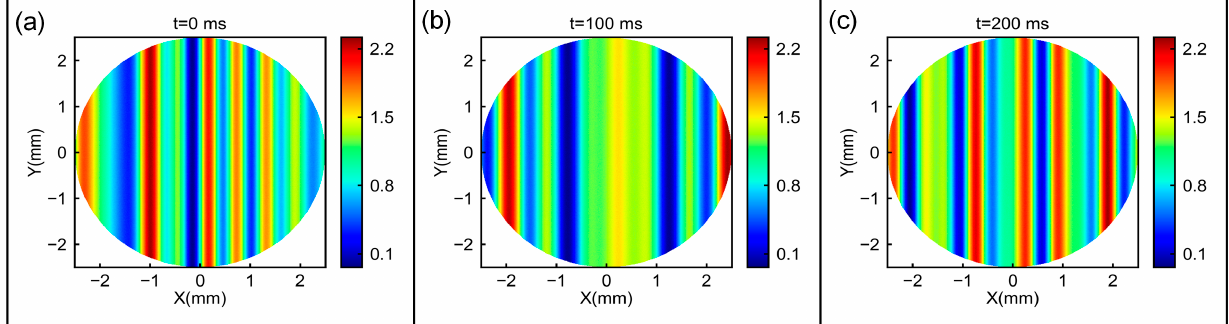
Figure 6. Wavefront reconstruction in video-frame rate. ( a – c ) Selected time lapse of wavefront reconstructed at a video-frame rate. SLM changed patterns in a specified sequence to simulate dynamically changing wavefronts.